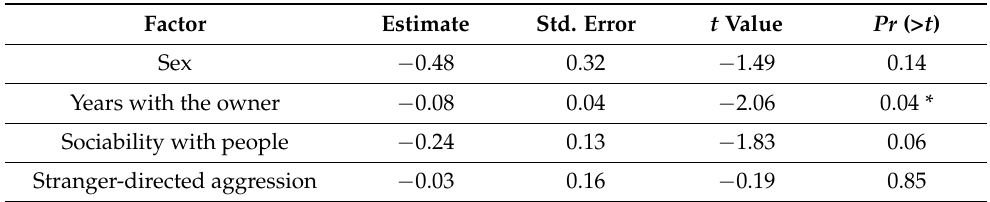
Table 2. Associations between eye angles and sex, years with the owner, sociability with people, and stranger-directed aggression. * p < 0.05.